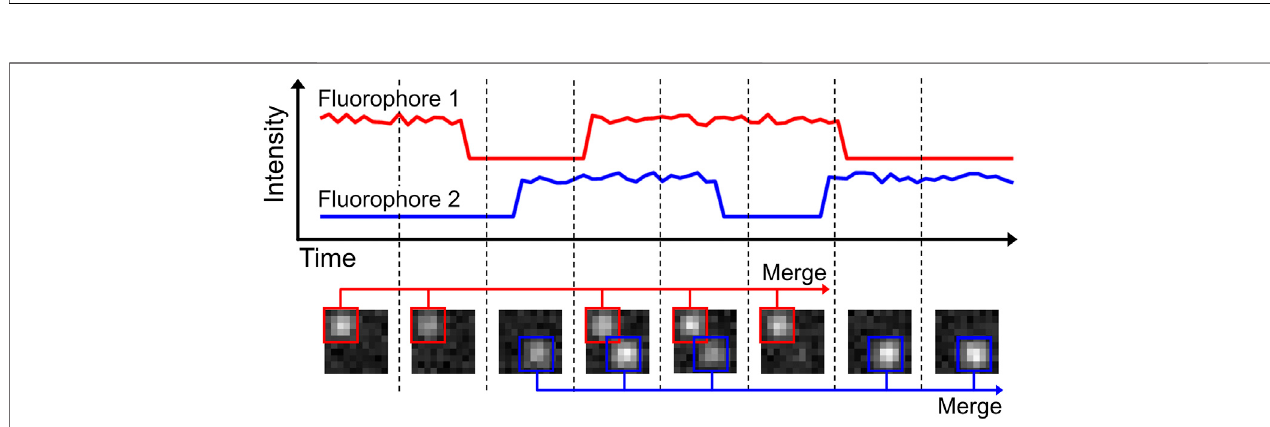
FIGURE 3 | Localization merging. In the shown example, two fl uorophores are present. Both fl uorophores are emitting for multiple frames, but are also blinking during this period. The localization merging routine identi fi es emitters that emit over multiple frames, accounting for possible blinking periods. Merging the